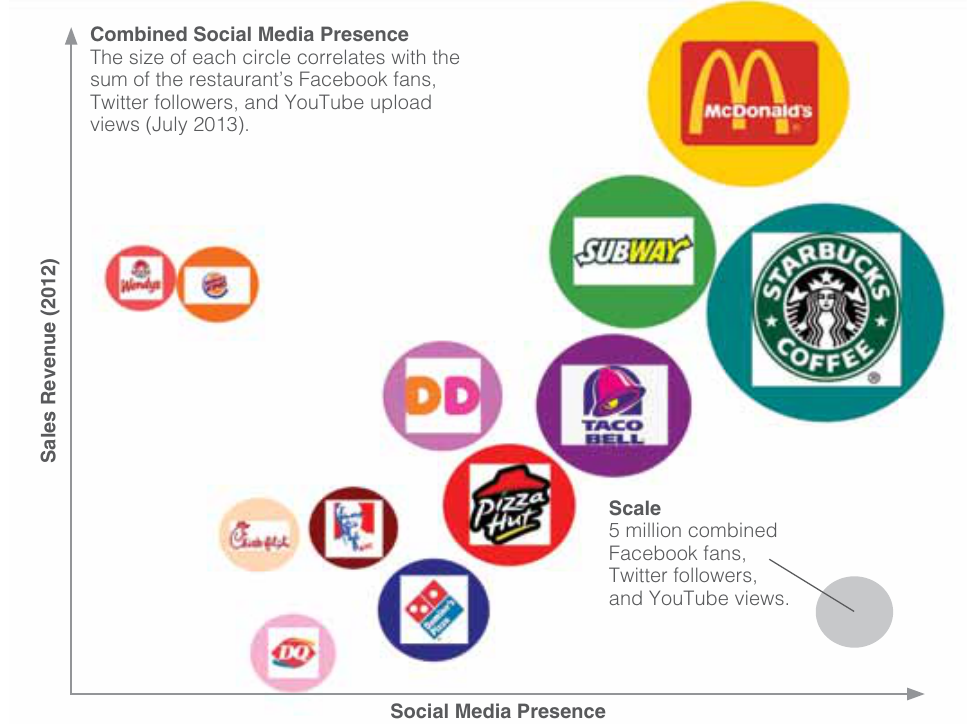
Source: Facebook, Twitter, and YouTube social media analysis (July 2013)